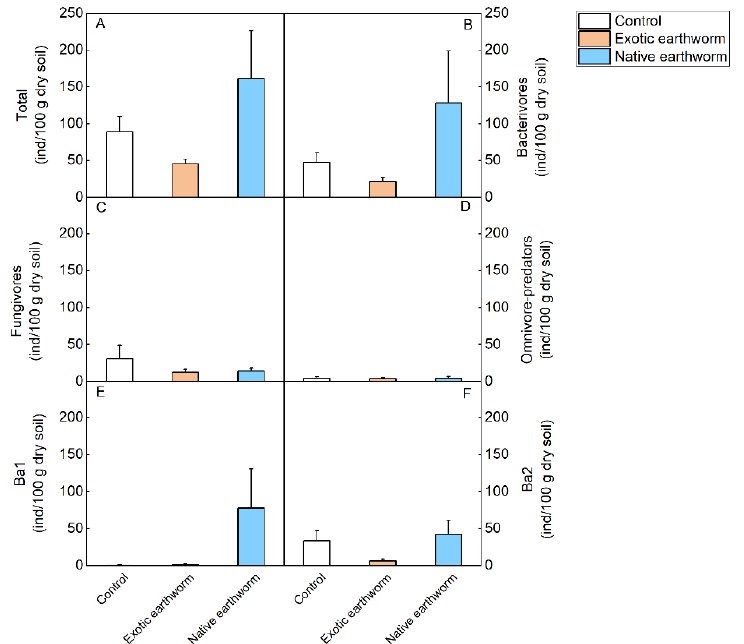
Figure 3. Comparisons of mean abundances of the nematode trophic groups and functional guilds as affected by the presence of exotic and native earthworms. Total ( A ); bacterivores ( B ); fungivores ( C ); O-P, the sum of omnivores and predators ( D ); Ba x represents the functional guilds that reflect the nematode trophic group of bacterivores; x is the c-p value ( E , F ). Data represent means + standard error (n = 5). No significant ( p < 0.05) effects based on one-way ANOVA (Table S5) were found.